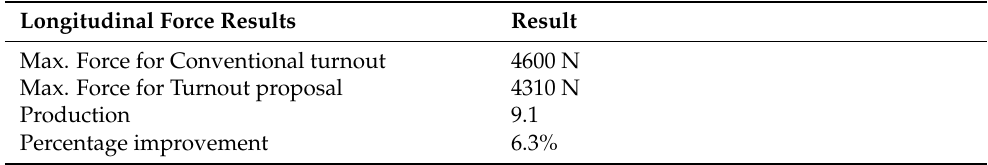
Table 6. Results obtained for the maximum longitudinal force of the left front wheel of the bogie.